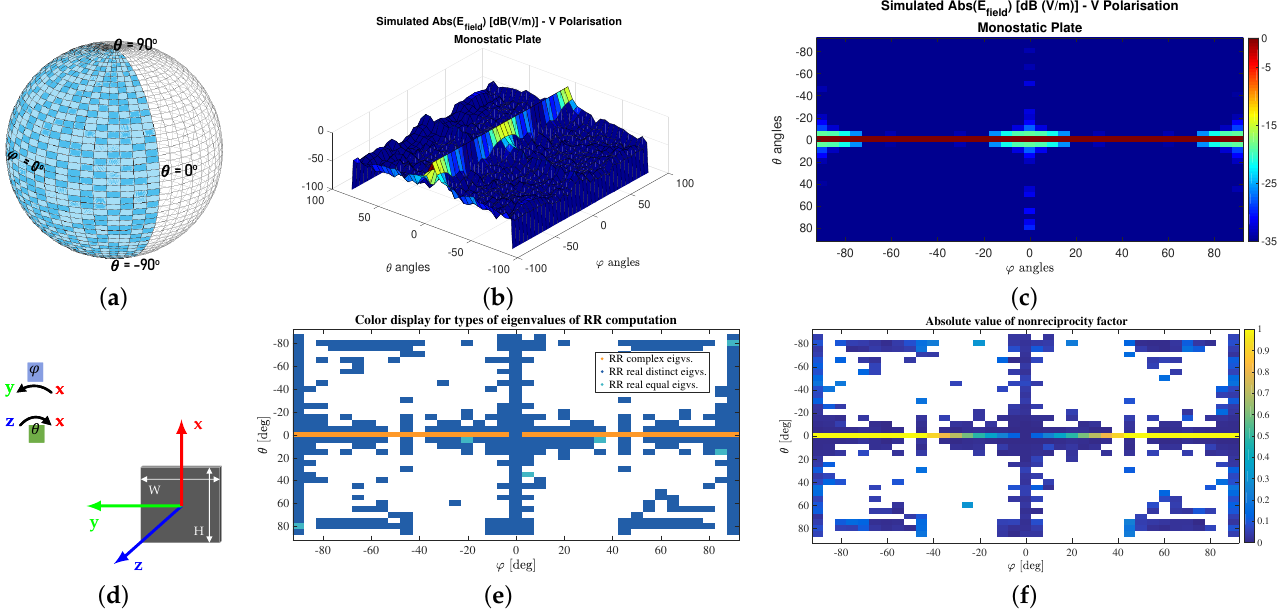
Figure 6. Square plate. ( a ) Range of incidence/scattered spherical positions for the monostatic simulations. (b) Normalized absolute value of simulated scattered electric far-field E s ( b ) Vertical polarization, 3D. ( c ) Vertical polarization, 2D. ( d ) Square plate representation in the general coordinate system. ( e ) Colormap display for RR eigenvalues classification of the plate’s monostatic response for a selection of observation directions in the investigated range. ( f ) Modulus of the nonreciprocity factor for the plate’s monostatic response for a selection of observation